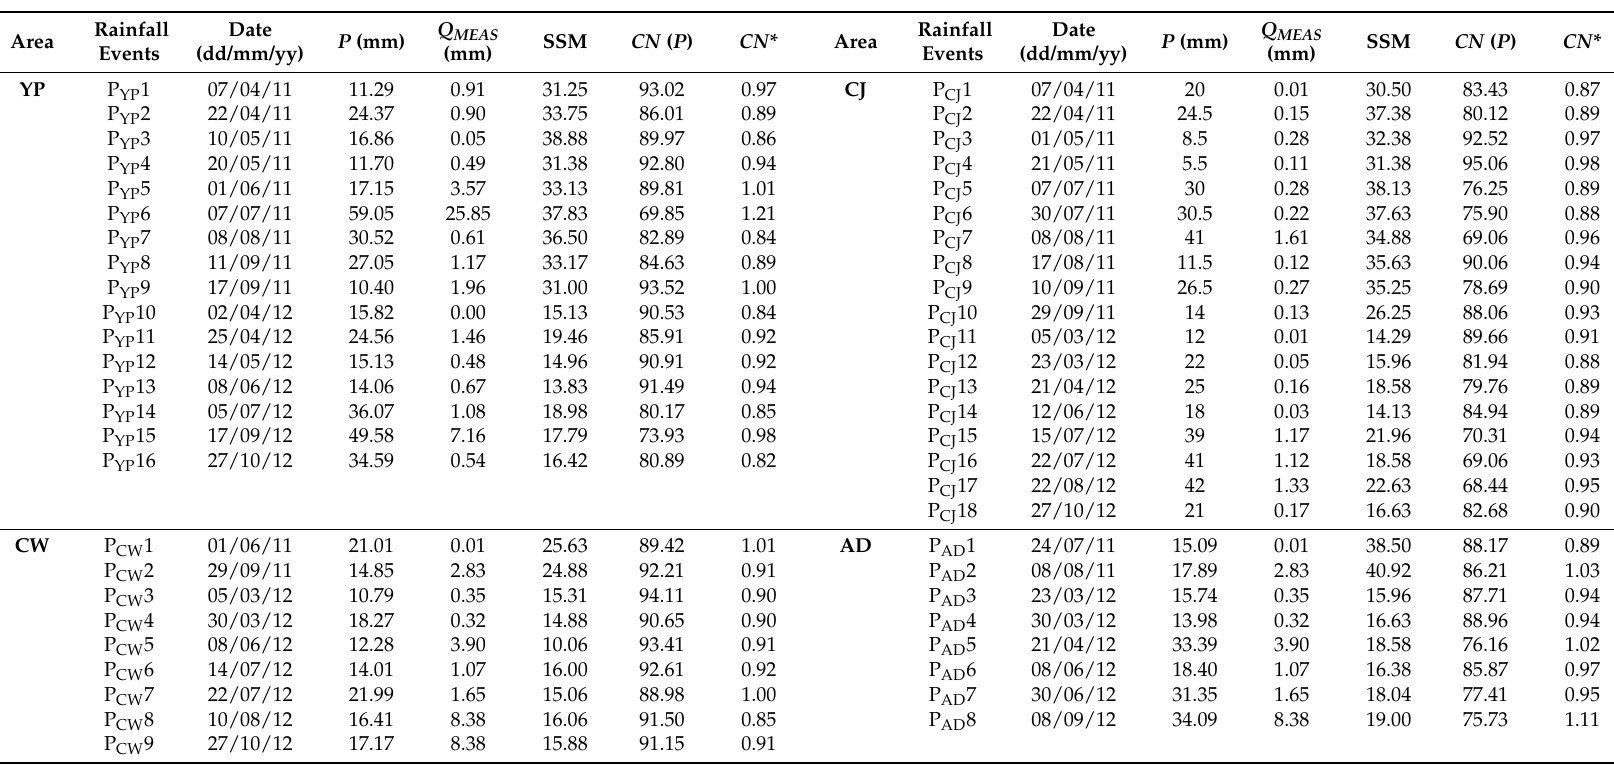
Table 6. Main characteristics of the selected rainfall–runoff events for evaluation of estimated runoff depth, remotely sensed surface soil moisture (SSM) through ASCAT, CN ( P ) from CN–P relationship defined in Equations (6)–(9), and CN * normalizing CN in Equation (4) by CN ( P